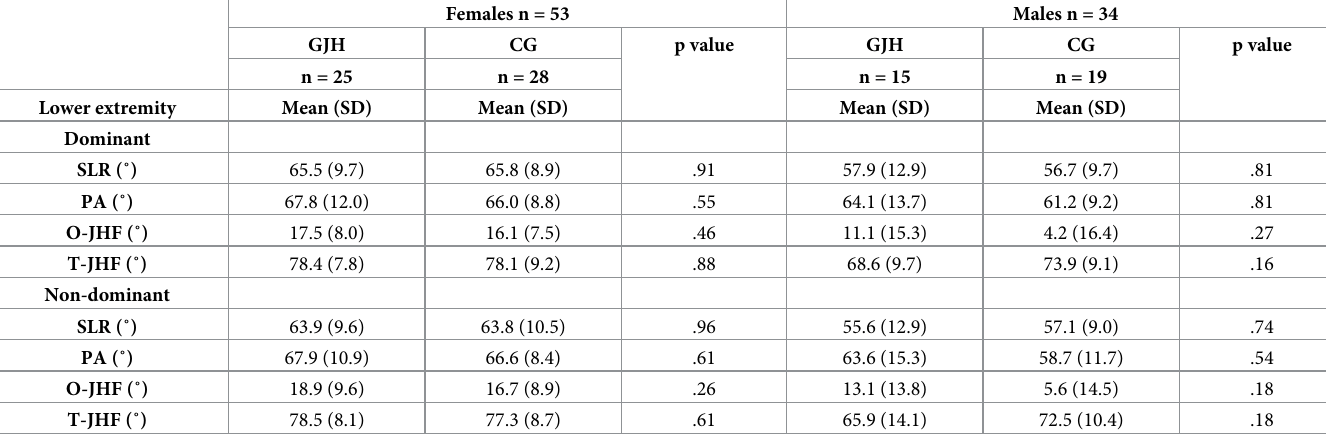
Table 3. The comparison of muscle flexibility tests between females and males with and without generalized joint hypermobility. Females n =